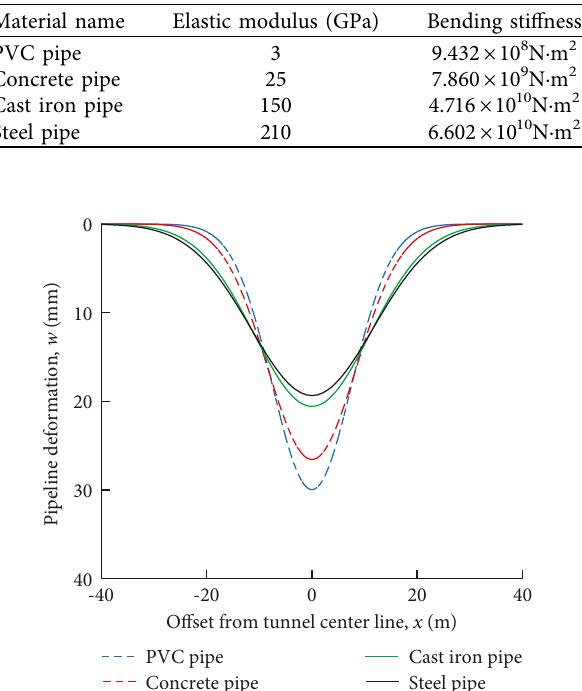
Figure 8: Pipeline deformation under different pipeline materials.